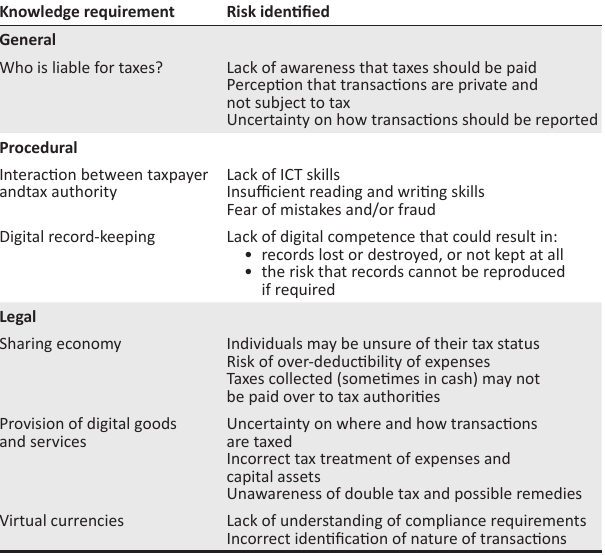
TABLE 1: Risks identified with respect to tax knowledge requirements for the digital economy. Knowledge